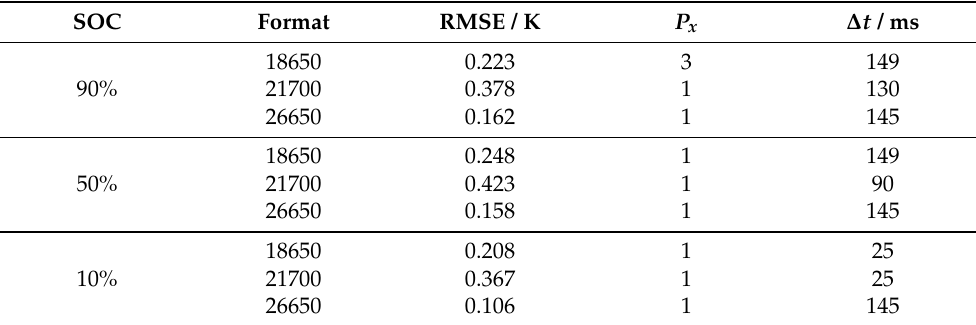
Table 4. Minimal fitting RMSE from Figure A6 for the different cell formats and SOCs with the corresponding pulse current types P x and ∆ t , which were used for the parametrization of the estimation function in Equation (4). SOC Format RMSE / K P x ∆ t / ms 18650 0.223 3 149 90% 21700 0.378 1 130 26650 0.162 1 145 18650 0.248 50% 21700 0.423 26650 0.158 1 18650 0.208 10% 21700 0.367 26650 0.106